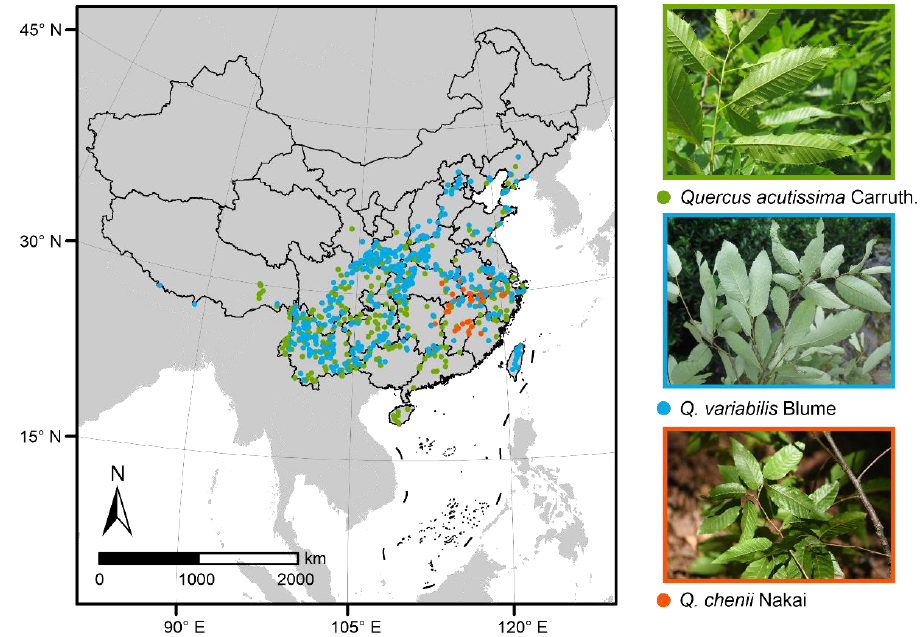
Figure 1. Maps of occurrence records and leaf photos (taken by Y.L.) of the three East Asian Cerris oaks. The green, blue and red dots represent the presence points of Quercus acutissima Carruth. ( n = 402), Q. variabilis Blume ( n = 431) and Q. chenii Nakai ( n = 52), respectively.